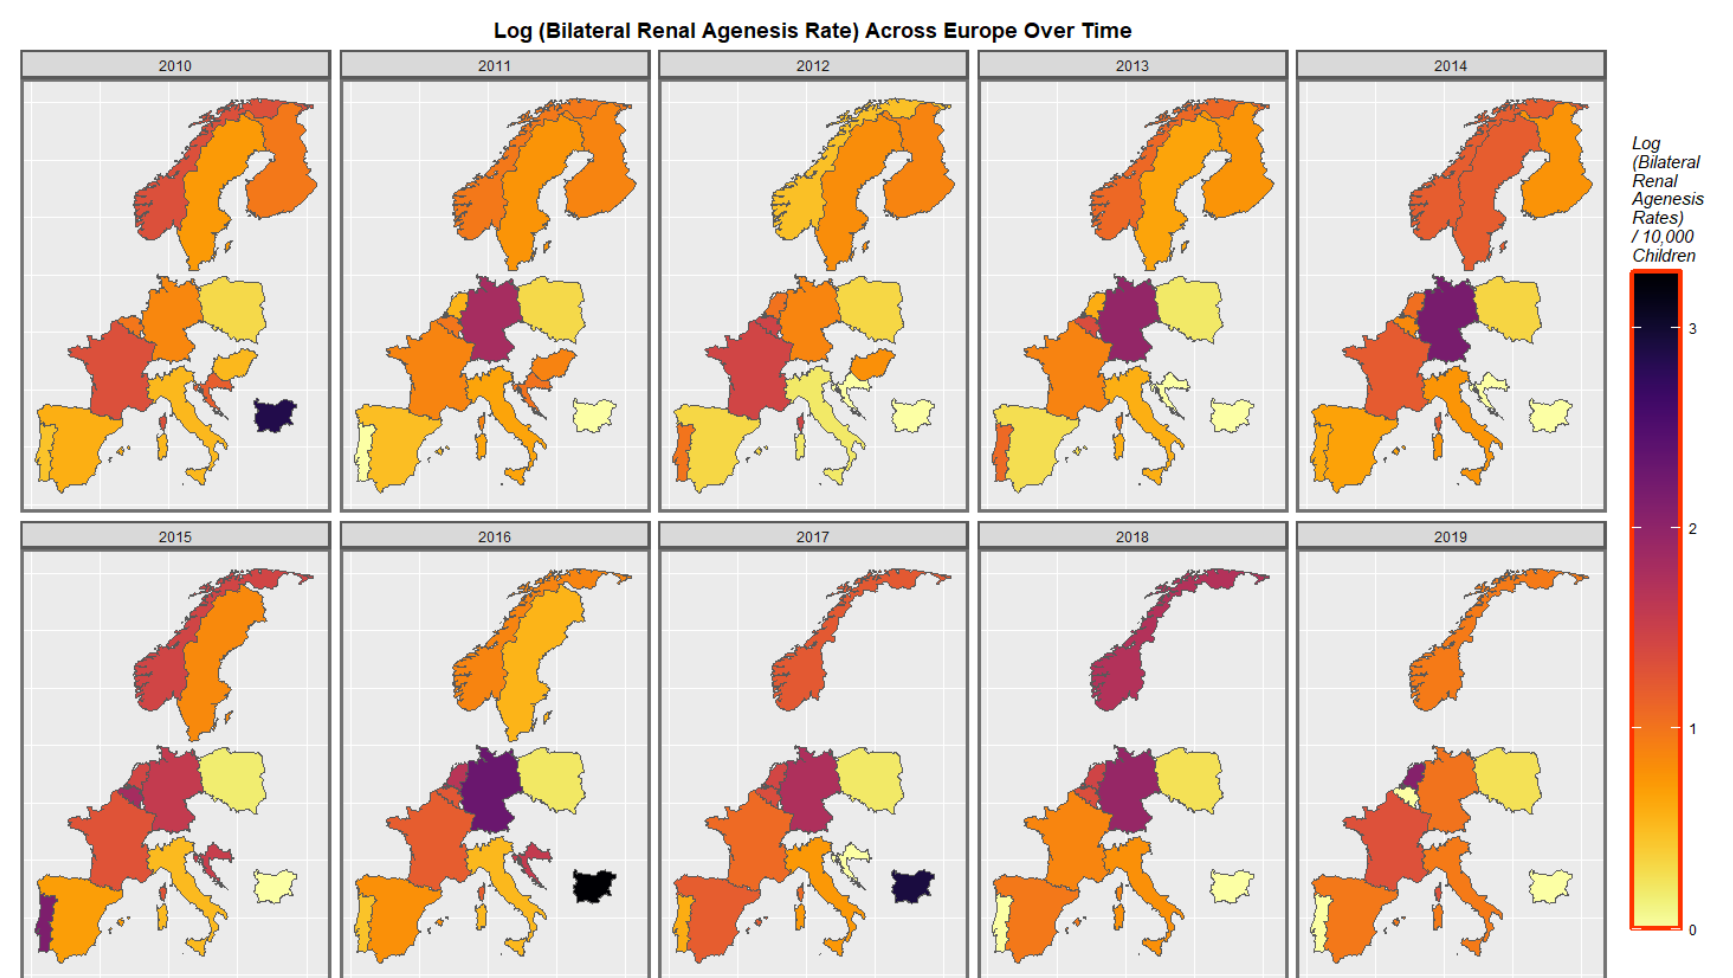
Figure 4. Time sequential map-graph of log (bilateral renal agenesis anomaly rate) across surveyed European nations over time.